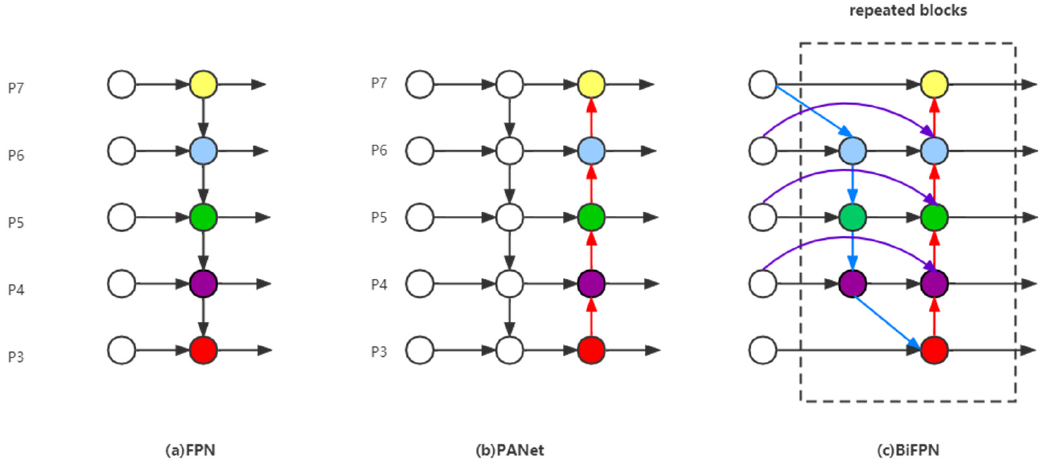
Figure 7. The architectures of three notable path aggregation networks. ( a ): FPN; ( b ): PANet; ( c ): BiFPN.